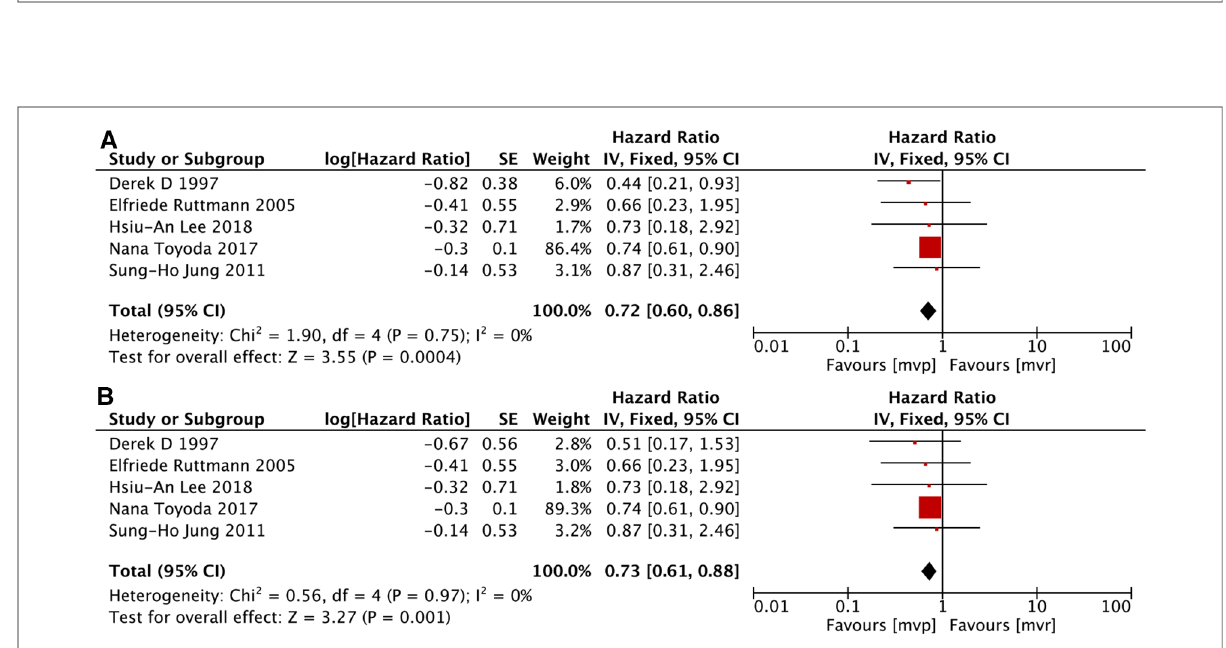
FIGURE 3 Meta-analysis for long-term survival: ( A ) MVP vs. MVR; ( B ) MVP vs. MVR (active IE); MVP, mitral valve plasty; MVR, mitral valve replacement.